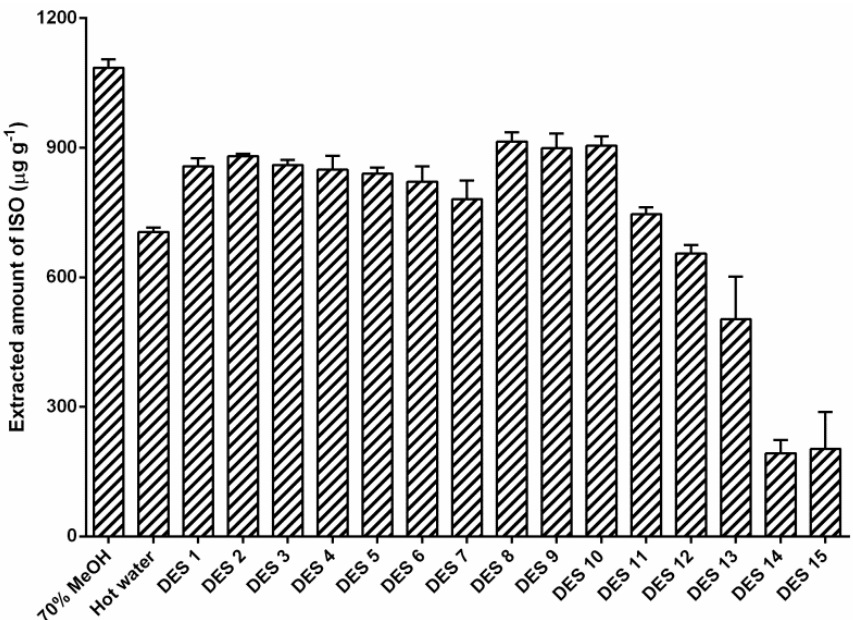
Figure 1. Comparison of isoquercetin (ISO) levels post extraction with DESs, to those post extraction with 70% methanol and water. The water content of all the tested DESs was 30% w / w. Error bars indicate standard error of the mean (n = 3).